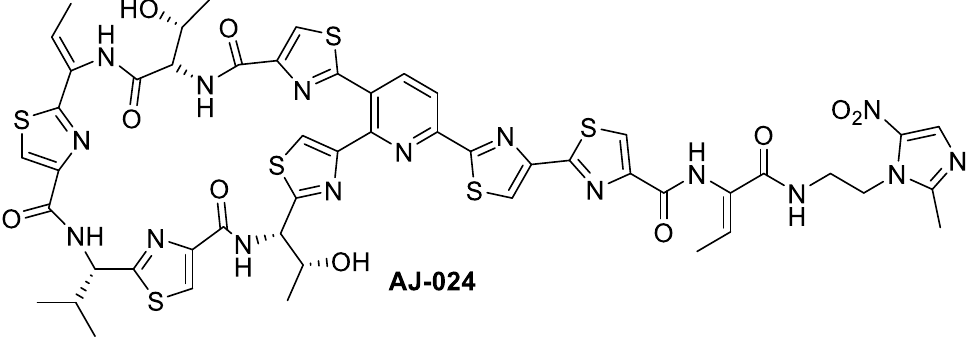
Figure 1. Chemical structure of AJ-024.